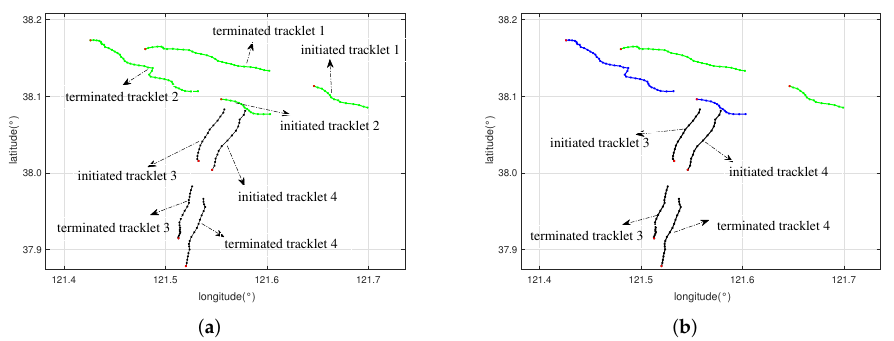
Figure 8. Intermediate association results of the proposed method. ( a ) Rough association results using k-means clustering. ( b ) Association results after spatiotemporal